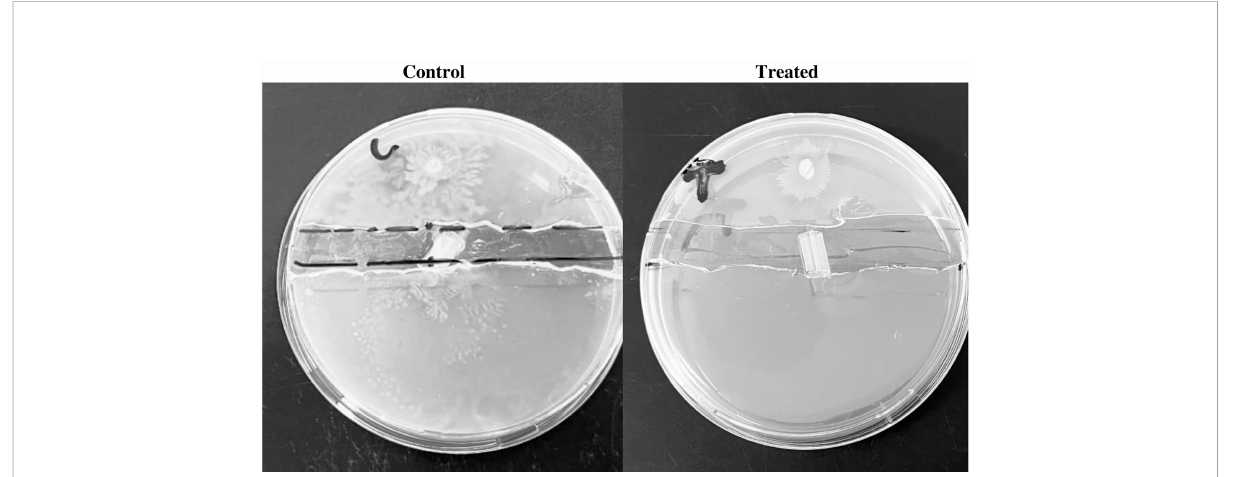
FIGURE 3 Indole impregnated silicone Foley catheter inhibit Proteus mirabilis migration by swarming morility. Representative images for the ef fi cacy of impregnated SFCs against P. mirabilis clinical isolate P8 swarming migration, control DMSO catheter segment, and Zch127 indole extract- treated catheter segment with (0.6 mg/mL).